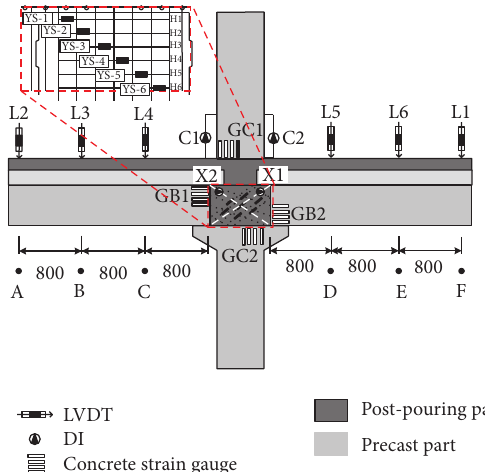
Figure 4: Measuring points arrangement for specimens.